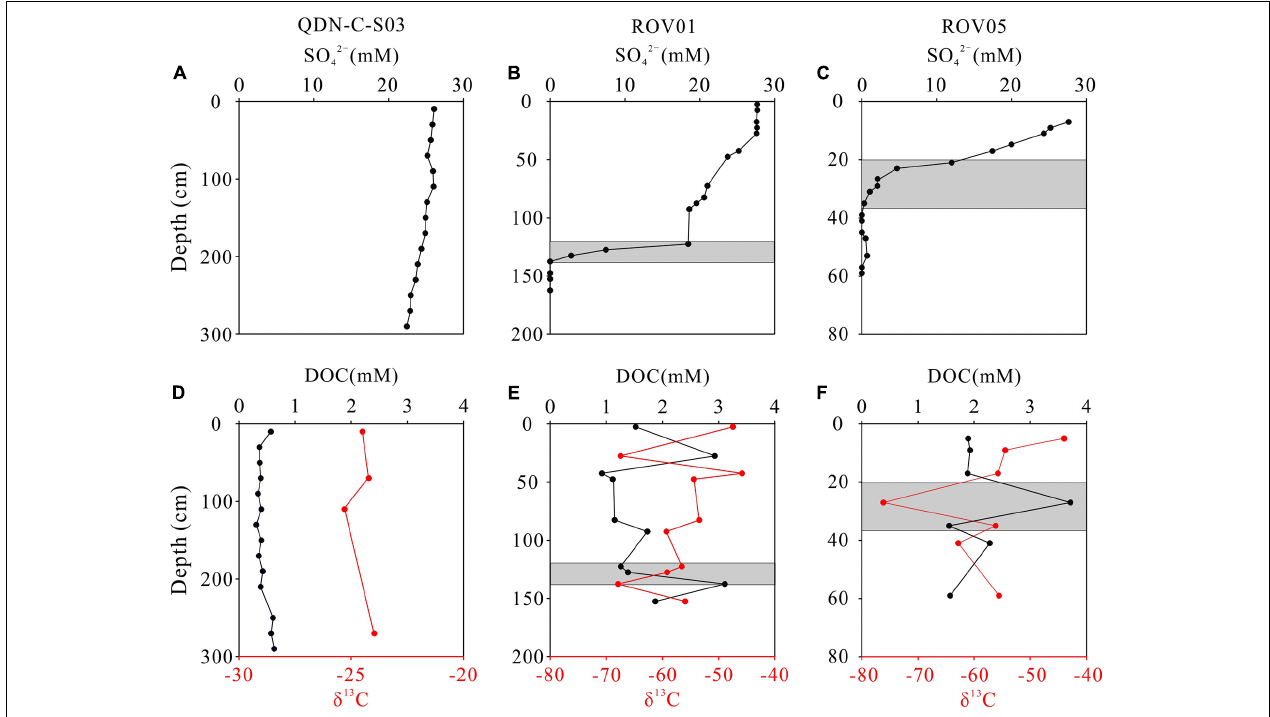
FIGURE 2 | Downcore profiles of pore-water SO 42 – , dissolved organic carbon (DOC), and δ 13 C-DOC at QDN-C-S03 (A,D) , ROV1 (B,E) , and ROV5 (C,F) . Shaded areas indicate the depths of the SMTZ.